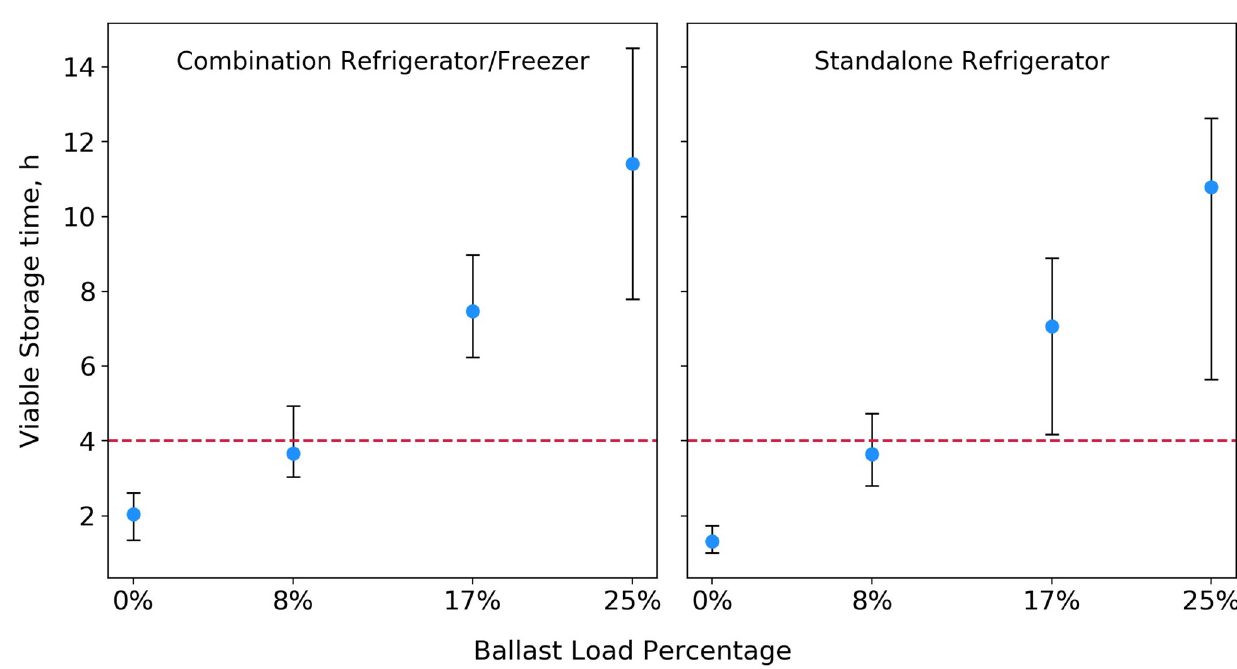
Fig 6. Viable vaccine storage time during power loss trials conducted with varying thermal ballast load percentages. Round blue markers indicate the average viable vaccine storage time achieved during each trial, and error bars show the range of these measurements, corresponding to the within-trial variation among monitored